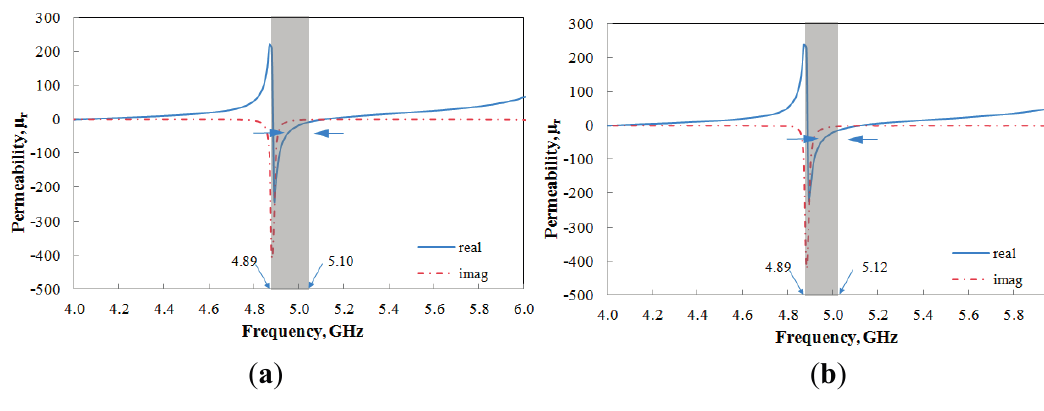
Figure 4. Effective parameters for ( a ) aligned-gap; ( b ) centered-gap sensor.